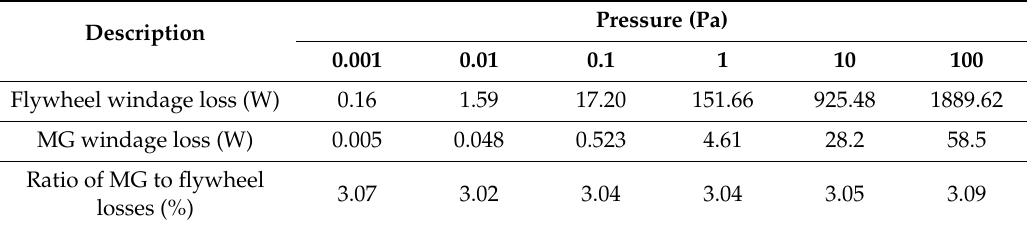
Table 2. Results of windage loss for flywheel rotor and MG relative to the pressure.